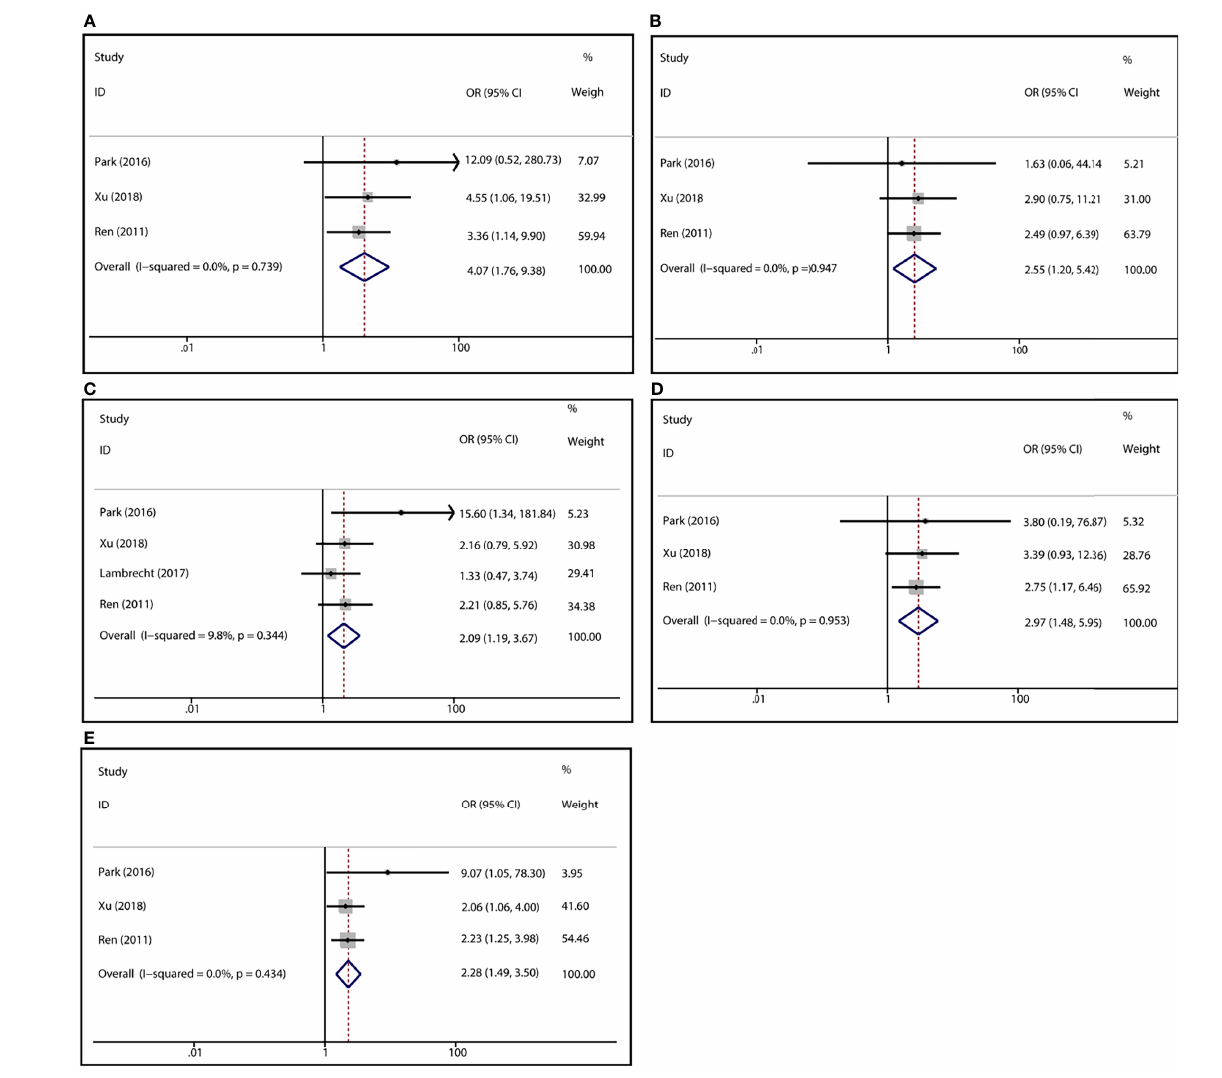
FIGURE 3 | Forest plots for the association between MTX-induced mucositis and MTHFR rs1801133 polymorphism. (A) homozygote comparison TT vs. CC; (B) heterozygote comparison TC vs. CC; (C) recessive genetic model TT vs. TC/CC; (D) dominant genetic model TT/TC vs. CC; (E) allele contrast T vs.